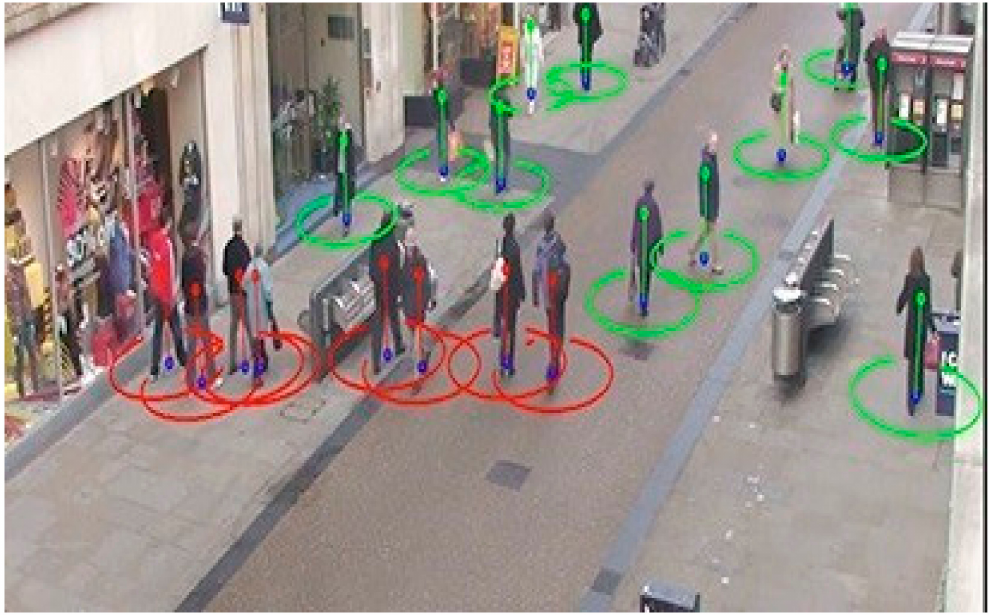
Figure 3. Crowd Tracking for COVID-19 SOP breachers